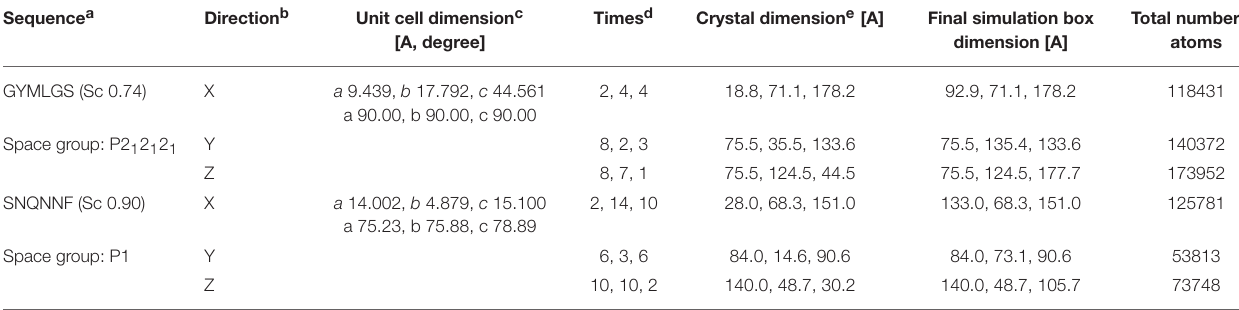
TABLE 1 | Summary of the sequence and structural properties of the amyloid peptide crystals. Sequence